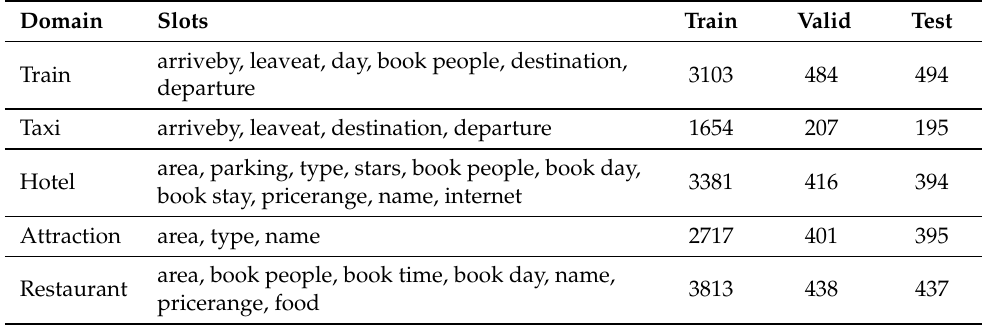
Table 1. Data statistics of MultiWOZ 2.1. Three columns on the right summarize the total number of dialogues in every